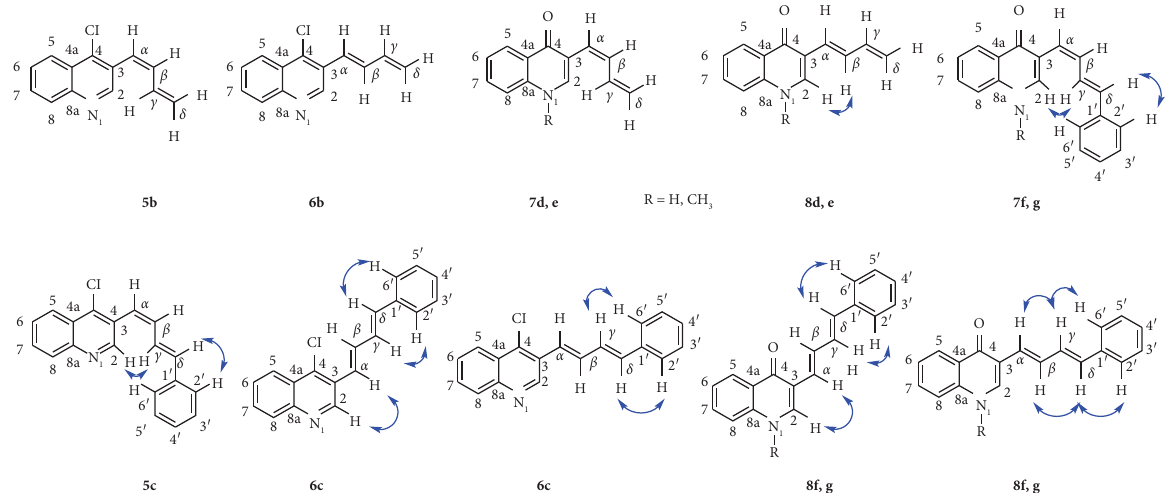
Figure 4: Structures of compounds 5b - c and 7d – g , their respective diastereomers, and the main NOE cross peaks observed in their NOESY